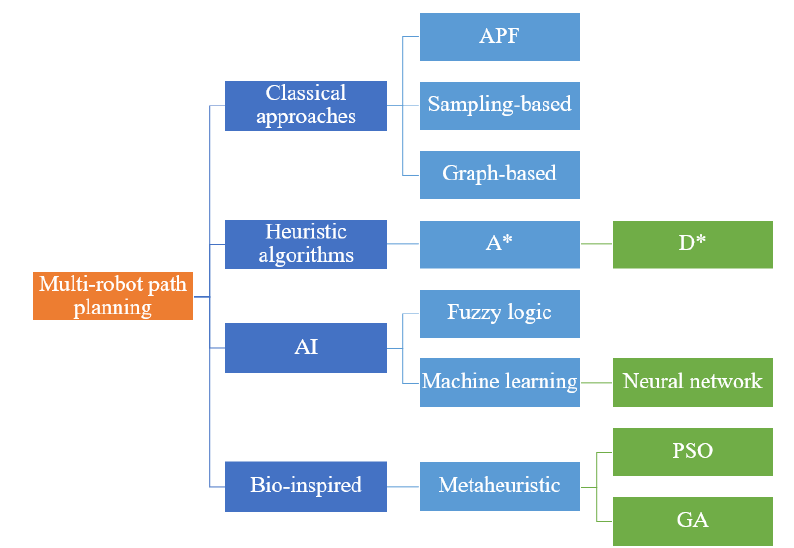
Figure 1. Classification of multi-robot path planning approaches.